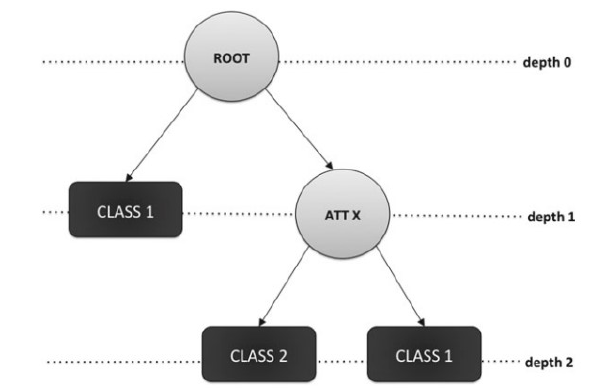
Figure 2. General structure of a